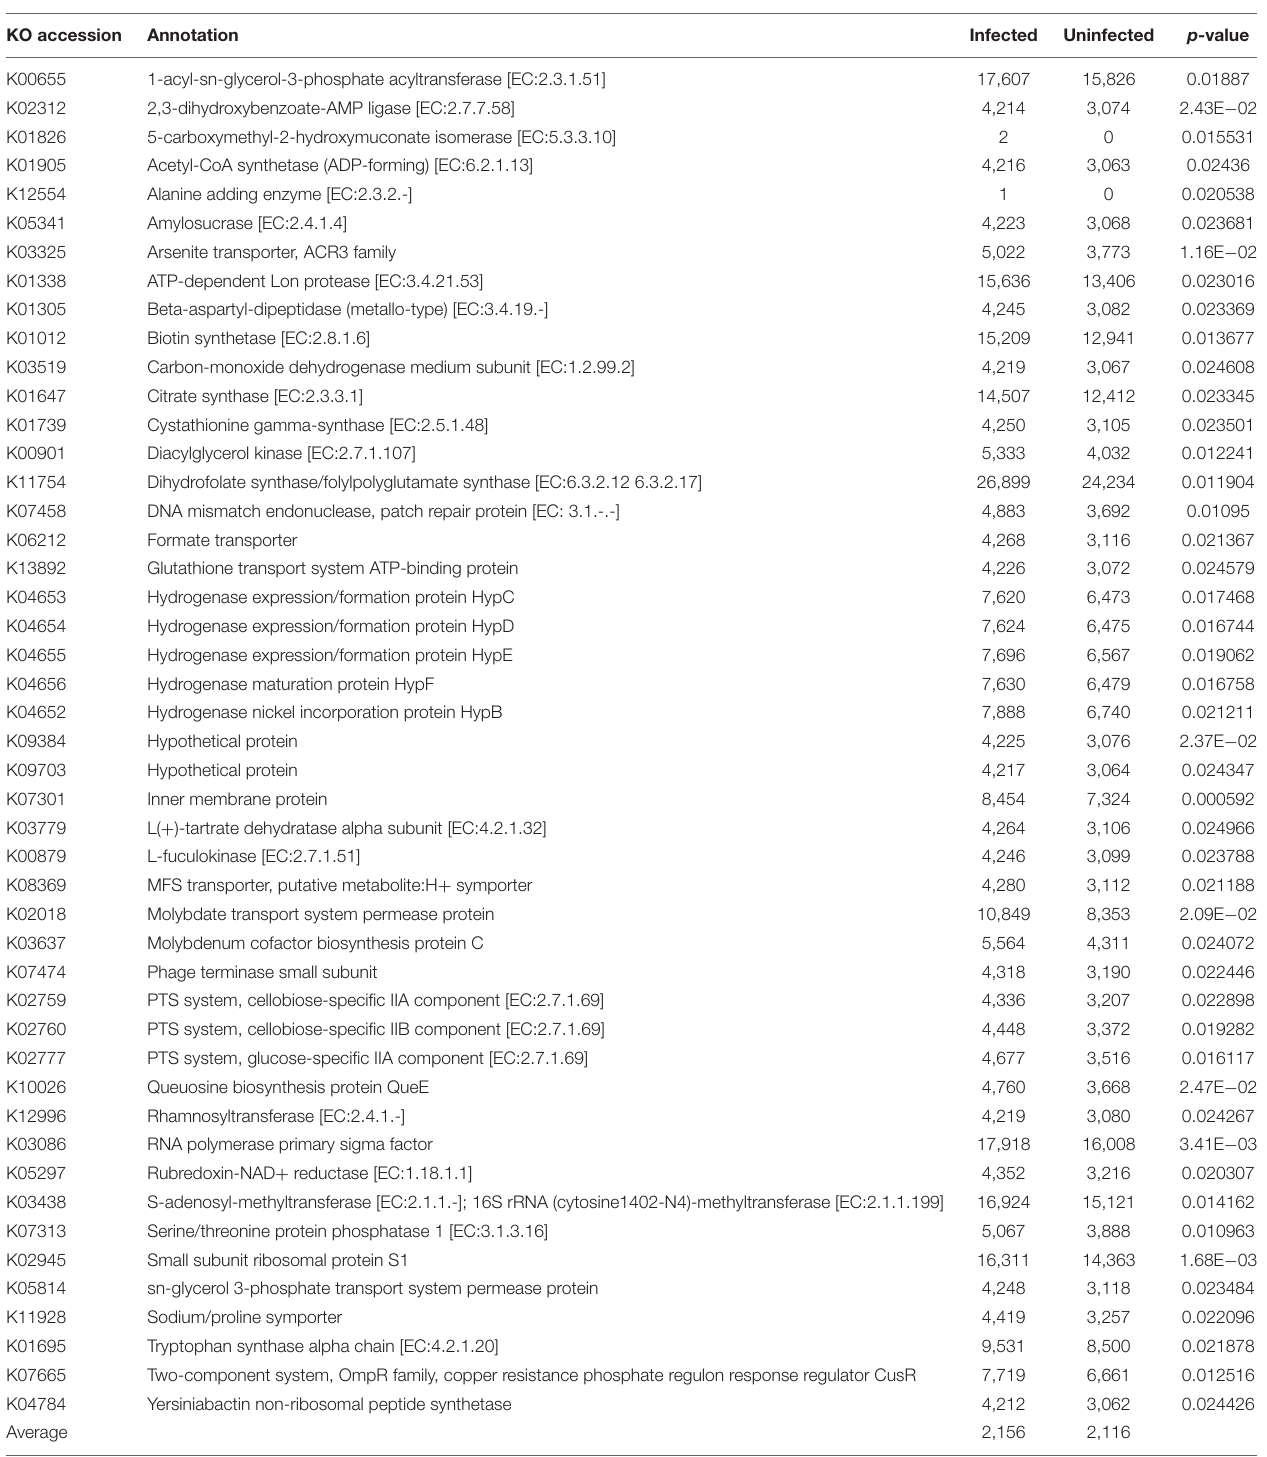
TABLE 6 | Functional predictions using the PICRUSt base on 16S rRNA gene copy